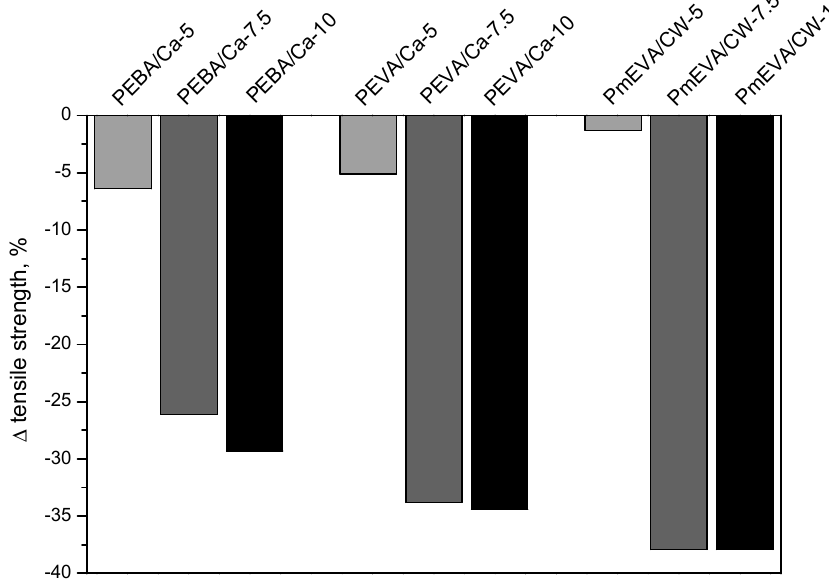
Figure 2. Influence of a MMT pre-dispersion type and MMT content (5, 7.5 or 10 wt. %) on tensile strength values of PE composites.